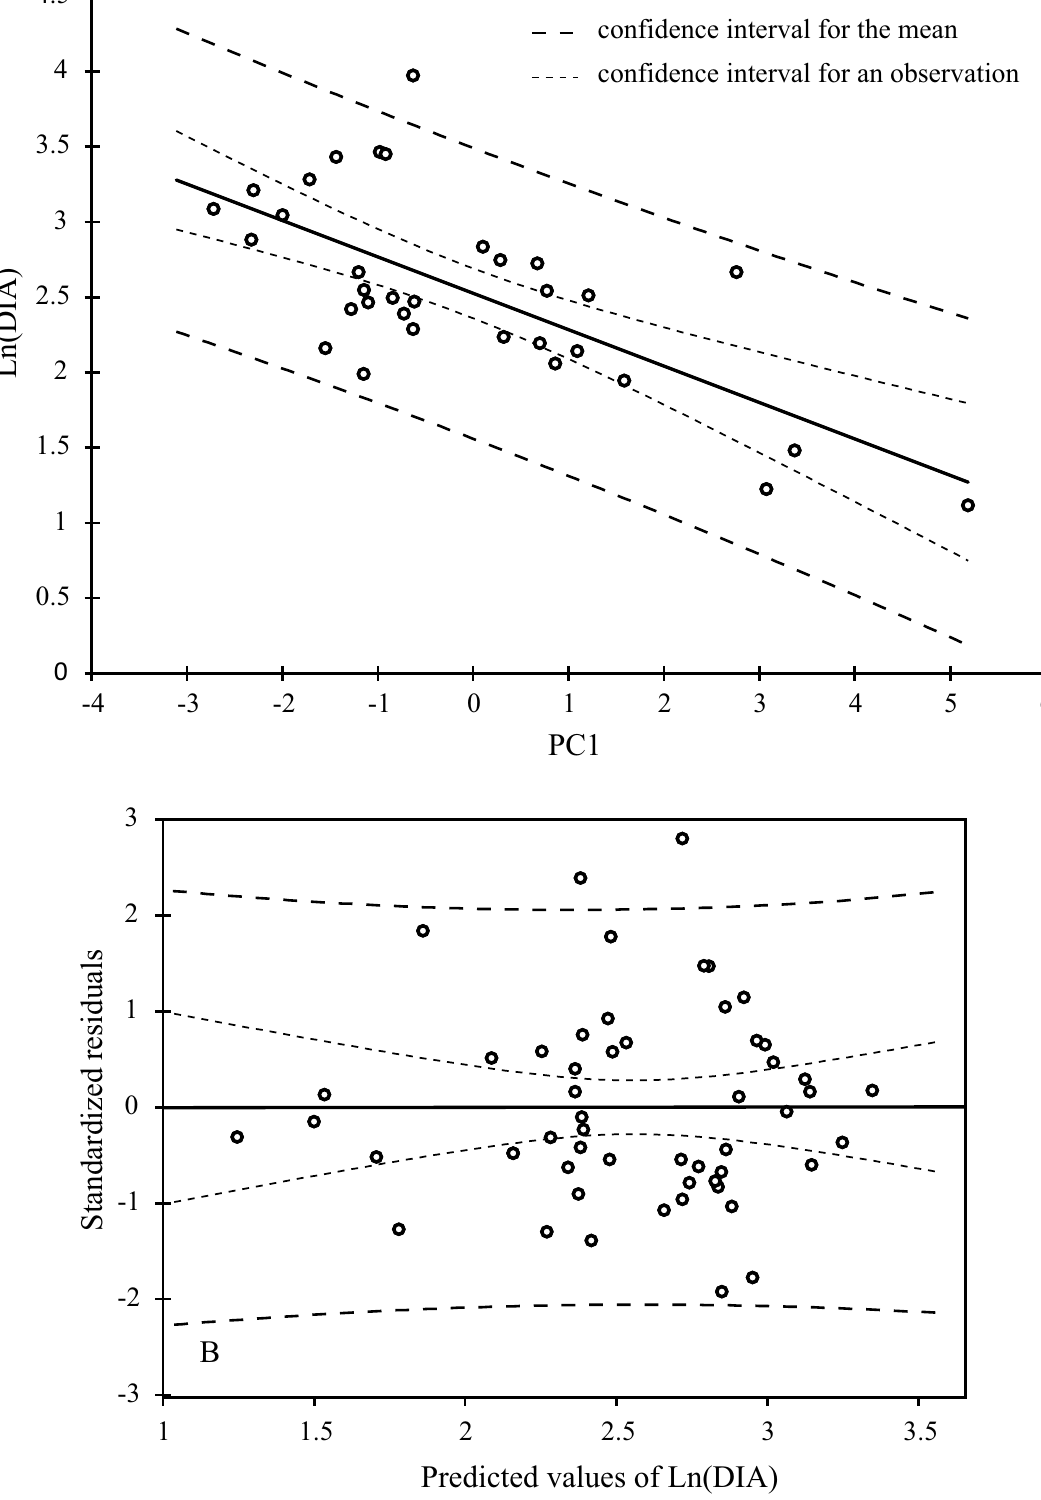
Figure 4. Linear predictive model of the branch diameter in relation to PC1 (Ln(DIA) = f(CP1)) and diagram of the standardized residuals of the